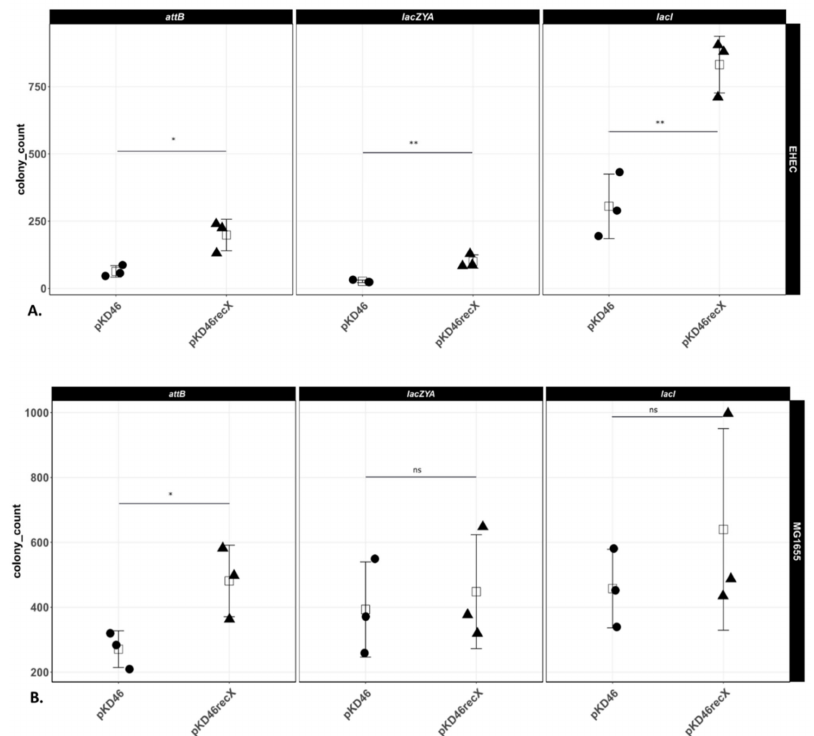
Figure 2. Numbers of chloramphenicol-resistant colonies obtained for the indicated genetic locus. ( A ) Number of chloramphenicol-resistant colonies in EHEC O157:H7 EDL933 ∆ stx1 / 2 . ( B ) Number of chloramphenicol-resistant colonies in E. coli K-12 MG1655. Shown are the average values of three technical replicates of three independent experiments. Statistically significant t-test comparisons are indicated by * ( p < 0.05), ** ( p < 0.01) and “ns” if not statistically